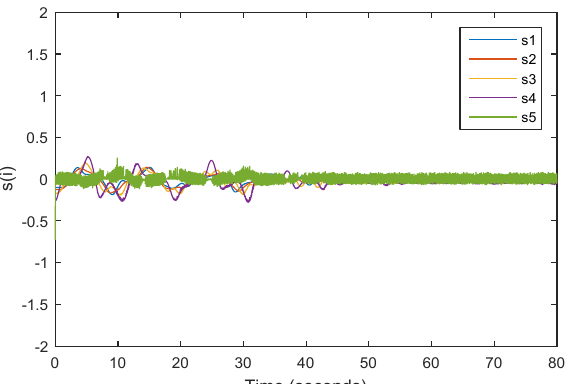
Figure 8. Sliding surface of the proposed sliding mode control